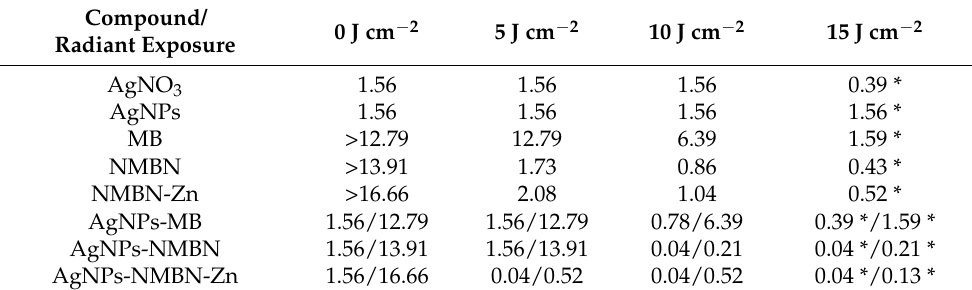
Table 1. Minimum inhibitory concentration (MIC) of AgNPs ( µ g mL − 1 ), phenothiazinium PS (MB, NMBN, and NMBN-Zn in µ g mL − 1 ), and AgNPs–PS in antimicrobial photodynamic treatment (APDT) against C. albicans . Compound/